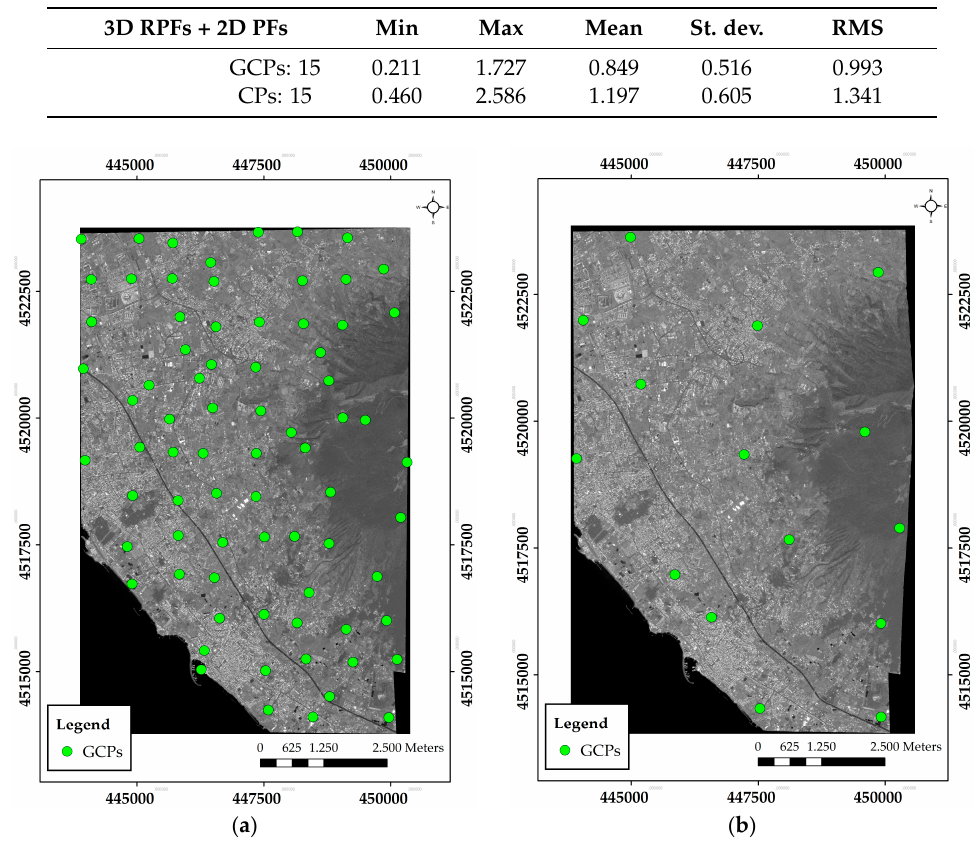
Table 8. Residuals (in meters) obtained with a combination of RPFs (75GCPs–15CPs) and PFs first order (15 GCPs–15 CPs).